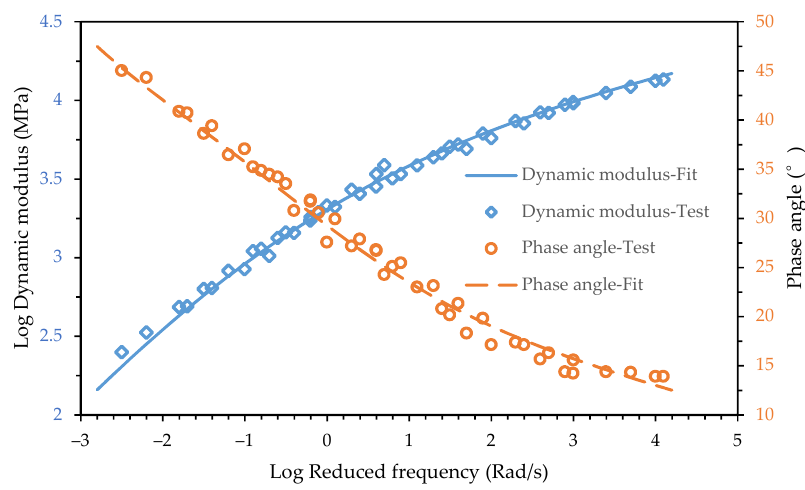
Figure 4. Test data and fitting curve of the asphalt mortar for the dynamic modulus and phase angle.